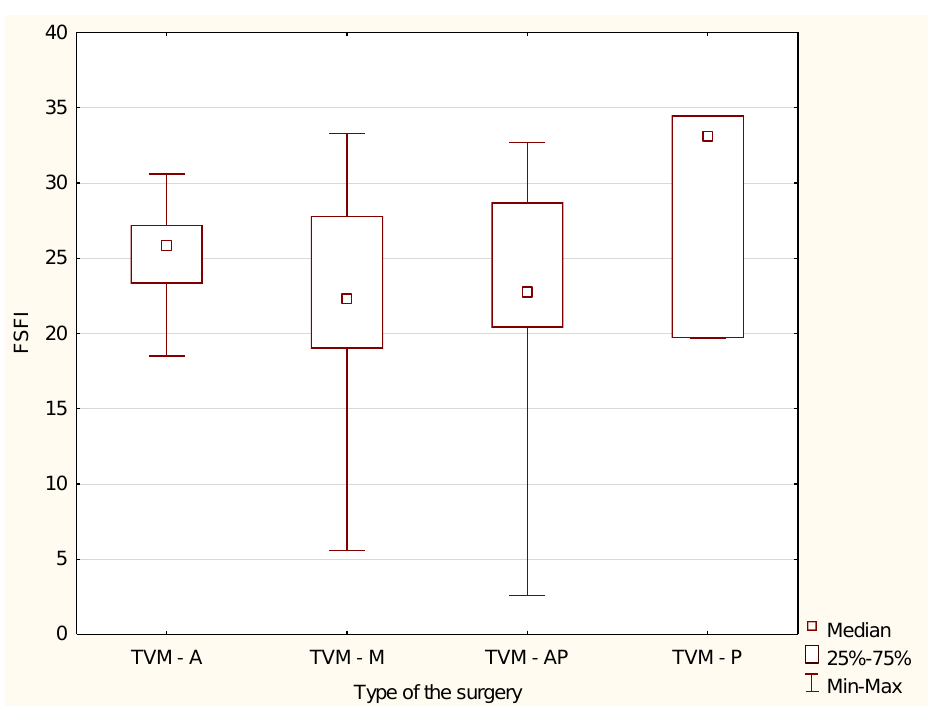
Figure 1. Median and range of FSFI results after TVM surgery depending on the place of mesh placement. TVM-A—TVM anterior; TVM-P—TVM posterior; TVM-AP—TVM anterior and posterior; TVM-M—modified transvaginal mesh.